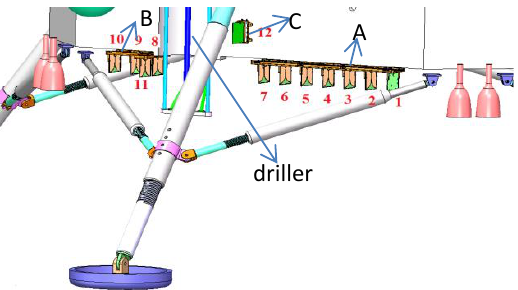
Table 1. Main Parameters of LRPR.